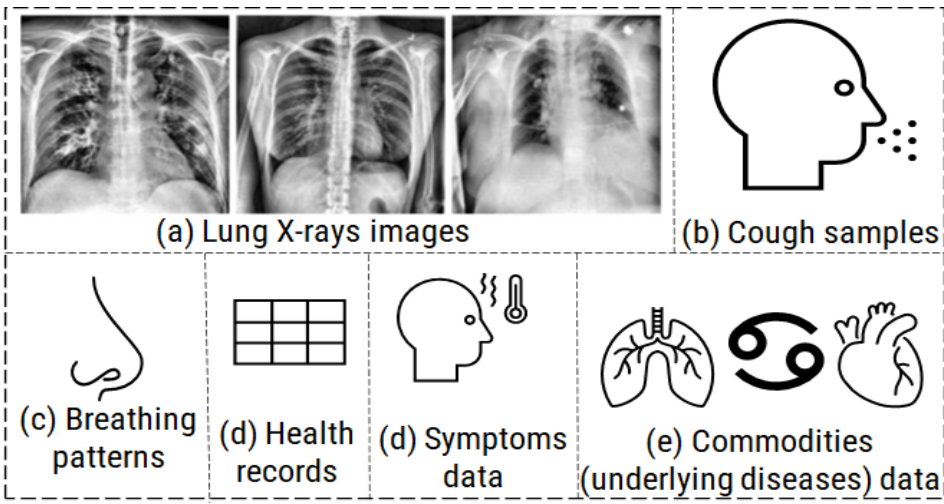
Figure 7. Overview of representative data types that were frequently used in COVID-19